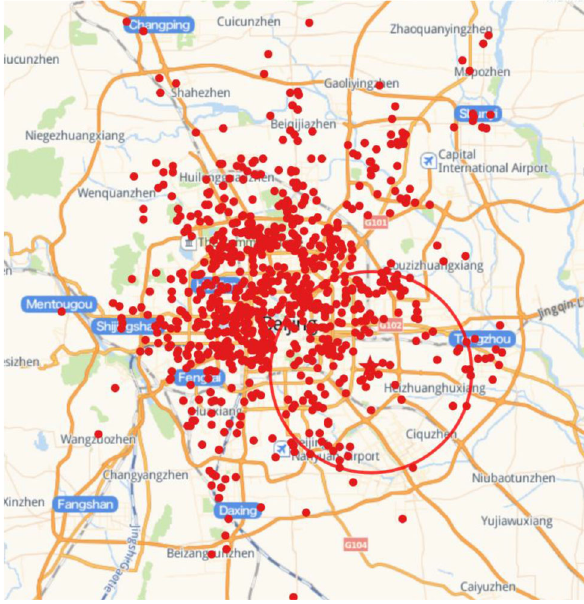
Fig. 4 Customer geographic distribution